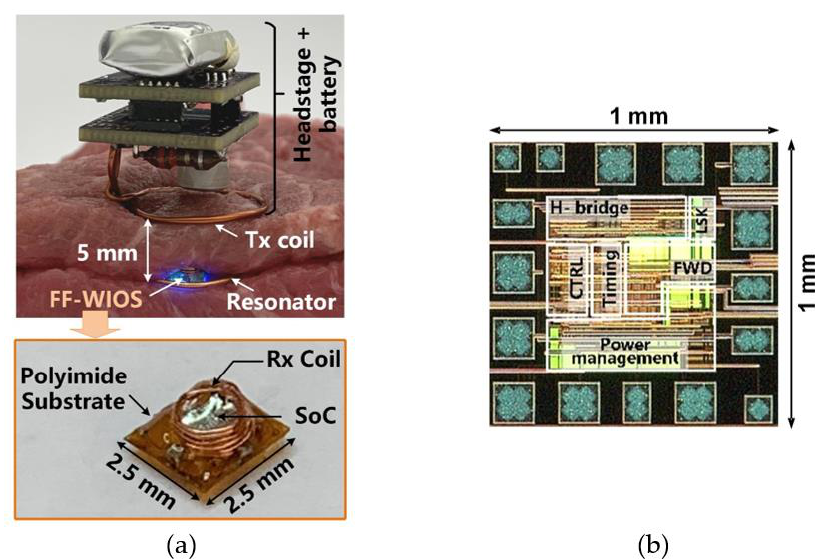
Figure 4. ( a ) In vitro system setup with a close-up view of the FF-WIOS2 device. ( b ) The fabricated FF-WIOS2 SoC micrograph.